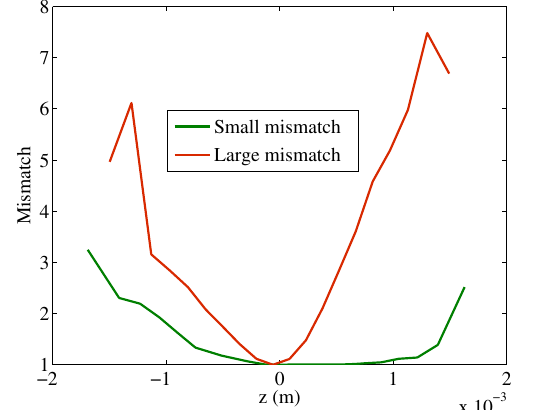
FIG. 20. Simulated horizontal slice emittance along the bunch for a compression factor of 15 using the large-mismatch bunch as input distribution at the entrance of the magnetic chicane. The vertical slice emittance is also shown for comparison.